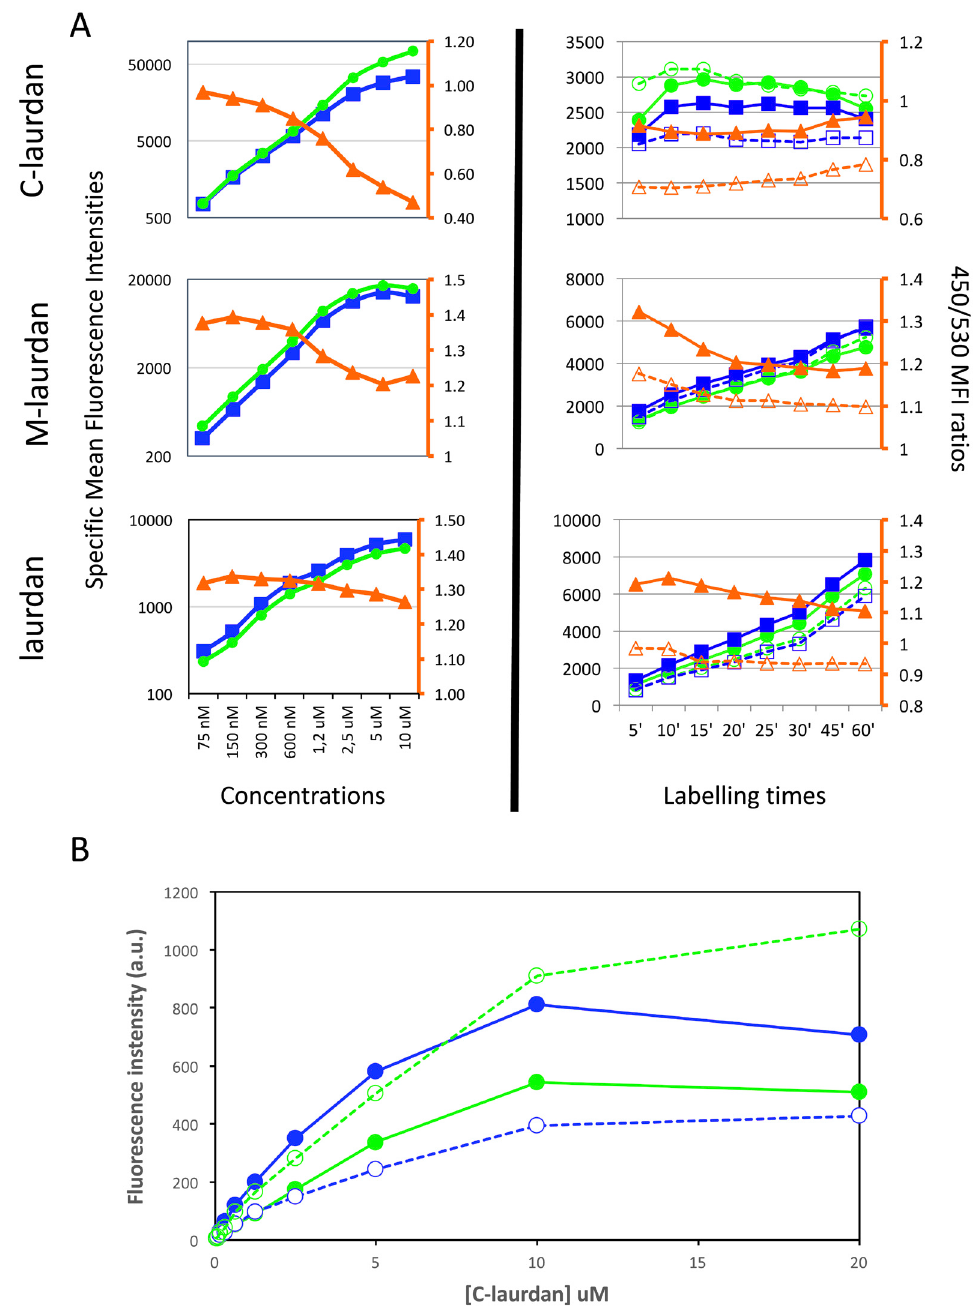
Figure 8. Using flow cytometry (FACS) to quantify staining intensities at 450 and 530 nm, as well as the ratio between the two. ( A ) FACS was used to quantify the mean fluorescence intensities (MFIs) of Hela cells labelled with C-laurdan (top), M-laurdan (middle) or laurdan (bottom). Blue squares indicate MFI at 450 nm and green circles indicate MFI at 530 nm, as plotted on the y-axis on the left side of each plot. Orange triangles indicate the ratio of 450/530 MFIs as plotted on the orange y-axis on the right side of each plot. The plots in the left column show dose–response curves after labelling cells at 37°C for 60 minutes. The plots in the right column show time courses of cells labelled at 37°C with either 200 nM C-laurdan, 500 nM M-laurdan or 4 µM laurdan. The unfilled blue squares and orange triangles indicate measurements as for the filled symbols, but on cells treated with 5 mM MßCD for 30 min at 37°C before labelling. ( B ) The preferential autoquenching of C-laurdan in Lo environments, suggested by the drop in the 450/530 ratio in the FACS analysis of cells labelled with high concentrations of the probe, can also be seen in MLVs analysed on a standard spectrofluorimeter. Serial two-fold dilutions of C-laurdan in DMSO were added (1% vol), whilst vortexing, to aliquots of MLVs prepared either with DOPC (Ld, dotted lines) or with DPPC–chol (Lo, continuous lines). After 20 min incubation at 37°C, the emission spectra of each aliquot were recorded in quartz cuvettes in a standard spectrofluorimeter (excitation: 360 nm), and the fluorescence intensities at 440 nm (blue lines) and 490 nm (green lines) were plotted against the concentration of